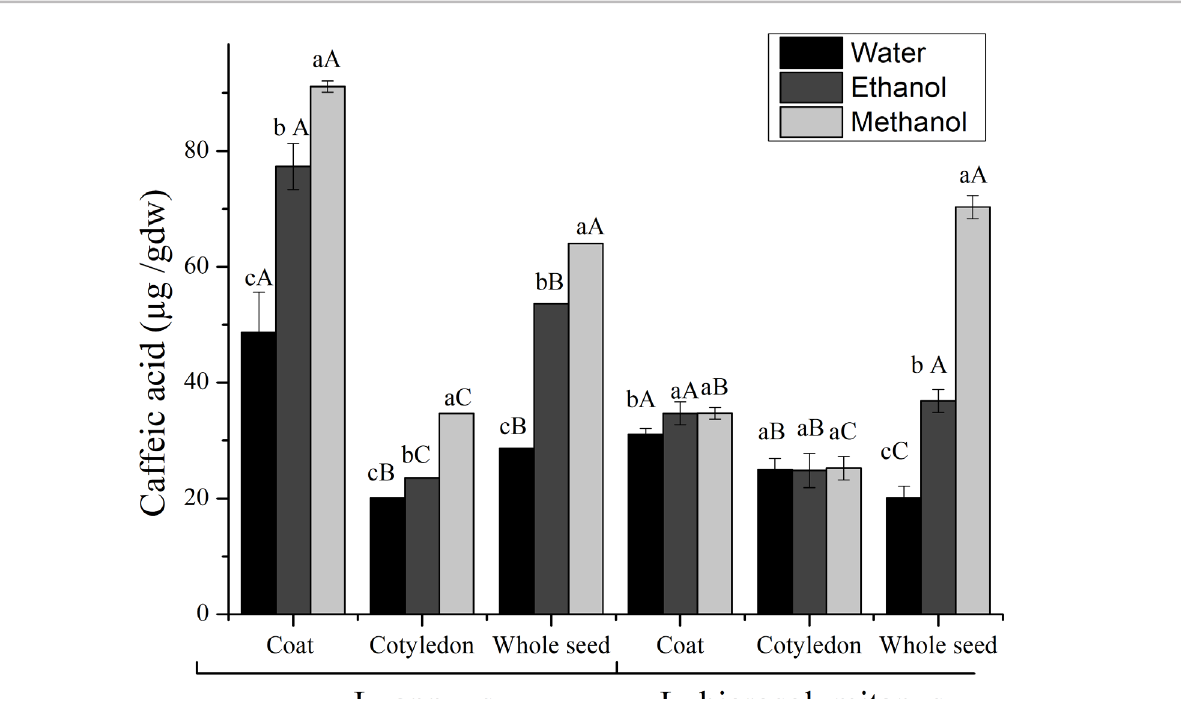
FIGURE 2 - Distribution of caffeic acid in Lathyrus seed extracts. Different letter show differences of means among different solvents for each part of each plant species (p < 0.05). Different caps letter shows differences between extracts from different part of the plant in the same solvent for Lathyrus species (p < 0.05).